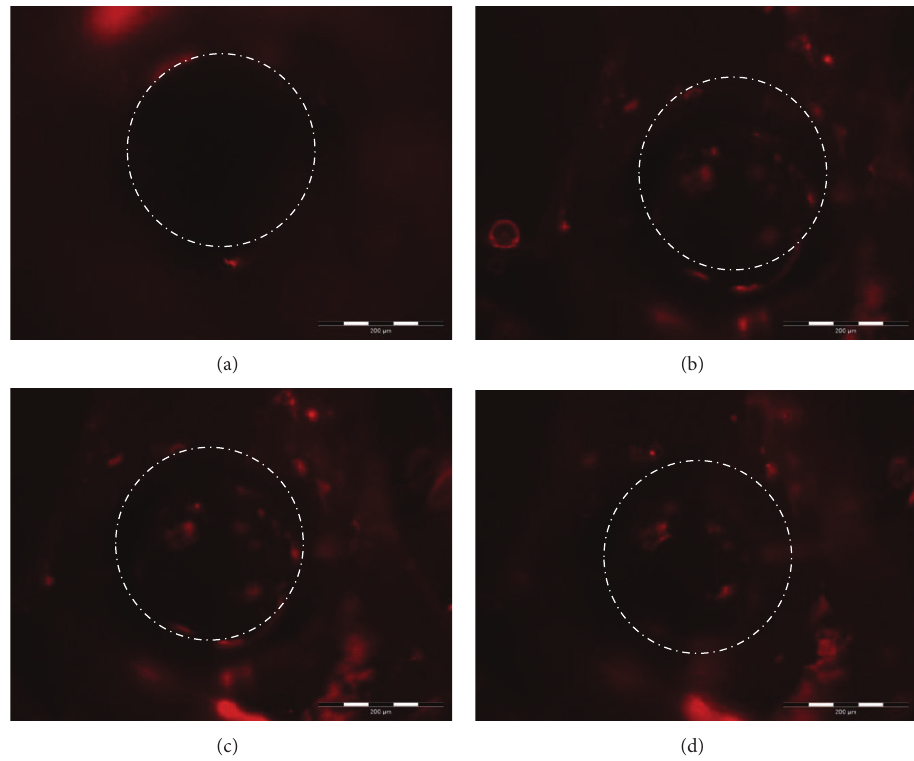
Figure 7: Results from hMSCs culture upon the PDMS sponges incorporating growth factors. Images taken at different depths to show cell penetration into pore (marked with dotted line). After a three-week culture process, cells (appreciated as prominent points in red) are well attached to the scaffold, have penetrated into the porous structure, and developed collagen (shown in red), helping to show the potential for tissue repair and cartilage generation of the proposed approach. Scale bar: 200 𝜇